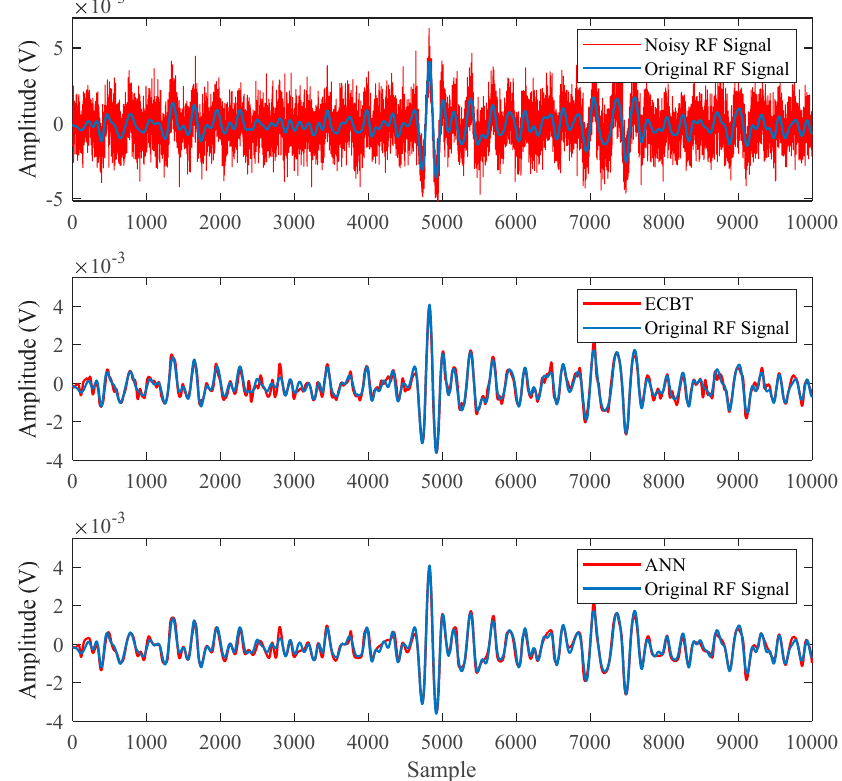
Figure 9. Results of denoising from RF signal in different noise levels where PSNR ranges from 1 to 2 by steps of 0.25, in the case of ‘crack’ type.